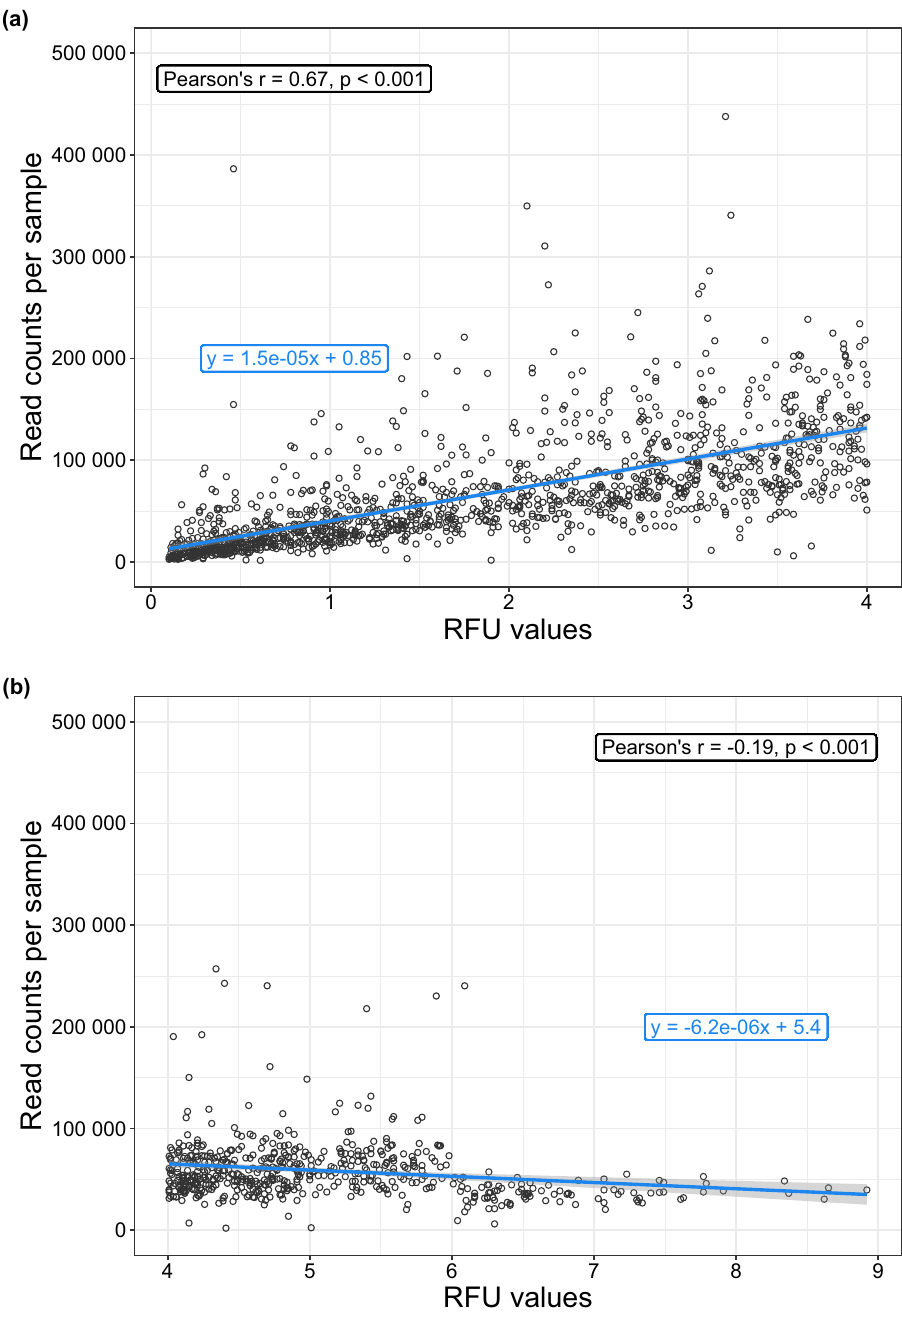
Figure 4. Influence of library preparation on sequencing depth visualized by plotting the outcomes of the NGS analysis against the signal strength of the products after library preparation that result from the two consecutive PCRs: that is the read counts per dietary sample (NGS) against the relative fluorescent units (RFU) of the automated capillary electrophoresis system QIAxcel for ( a ) small amounts of amplicons (≤ 4.0 RFU) and ( b ) larger ones (> 4.0 RFU). The individual dietary samples are represented by the